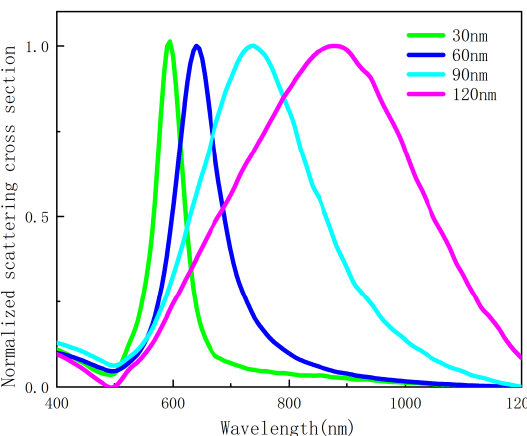
Figure 2. Scattering cross-section spectra of nanoscale hemispheres with different radii.